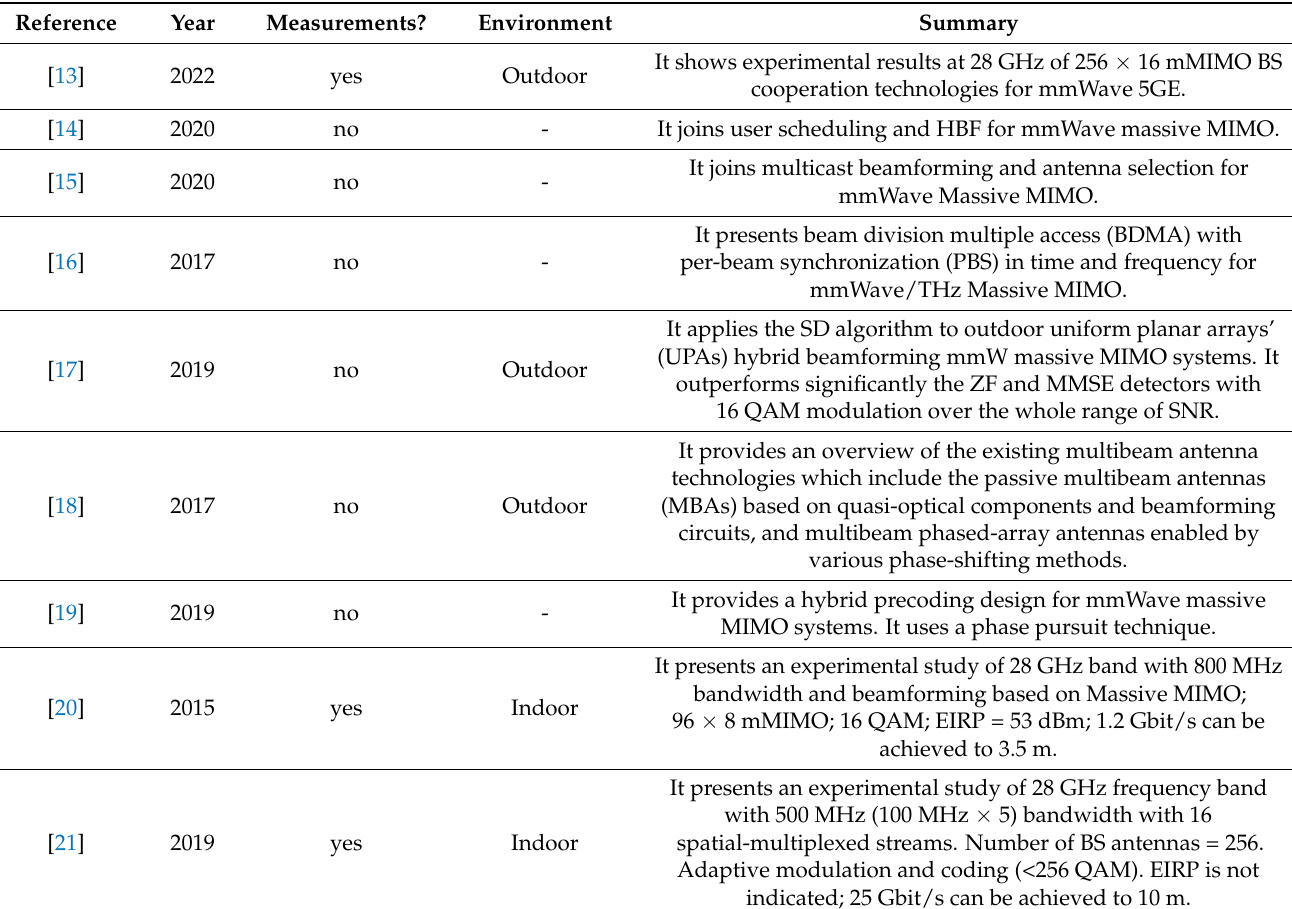
Table 1. Studies that discuss mmWave mMIMO